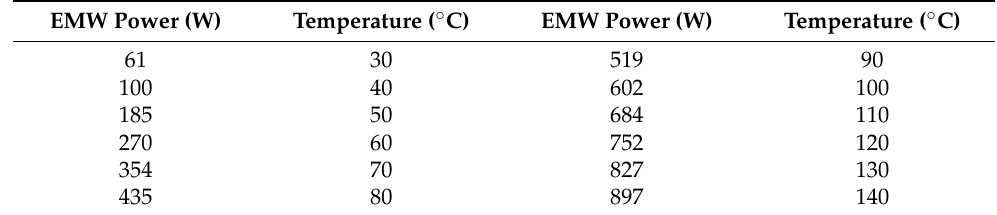
Table 3. The relationship between the electromagnetic wave power and the temperature of the